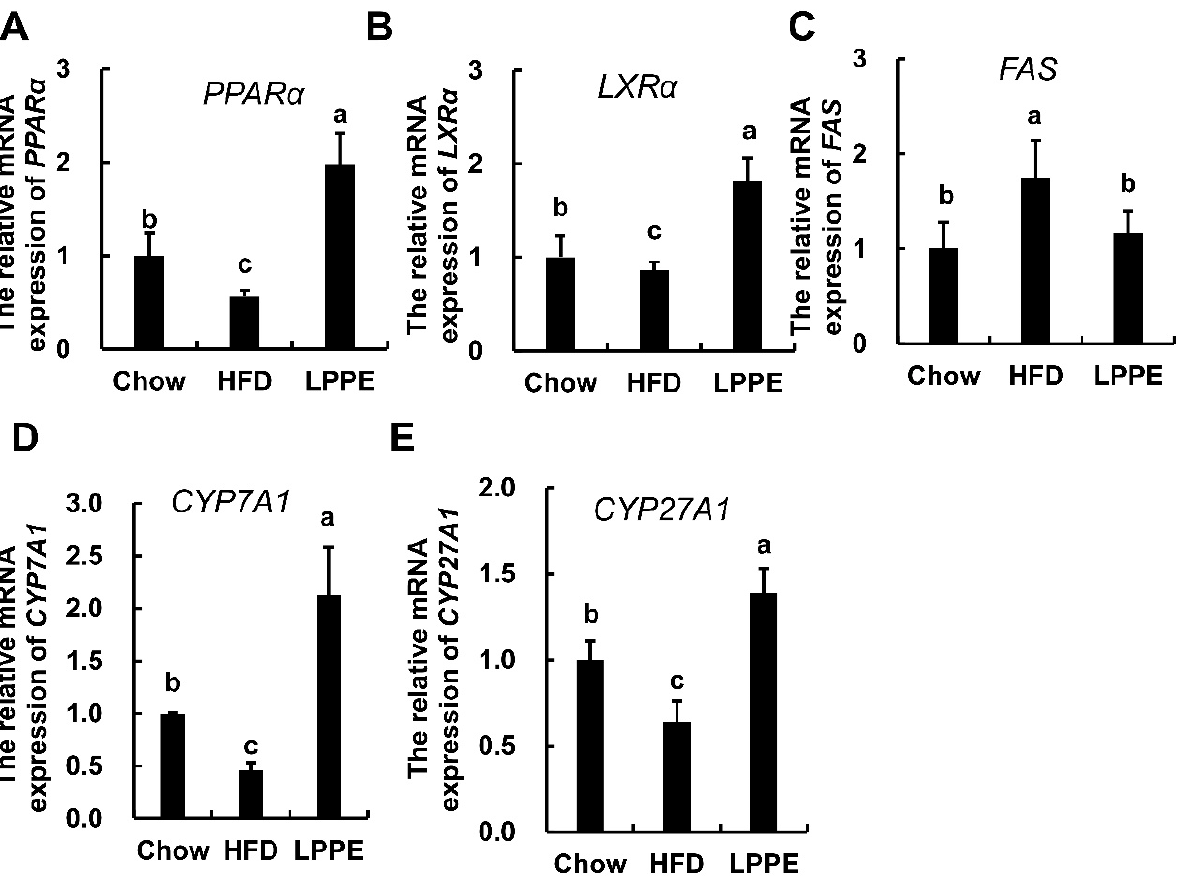
Figure 4. Effects of LPPE on the gene expressions involved in lipid metabolism. The mRNA expres- sion of hepatic PPAR α ( A ) , LXR α ( B ) , FAS ( C ) , CYP7A1 ( D ), and CYP27A1 ( E ). Values are expressed as mean ± SEM (n = 6). Different letters indicate significant differences ( p < 0.05).